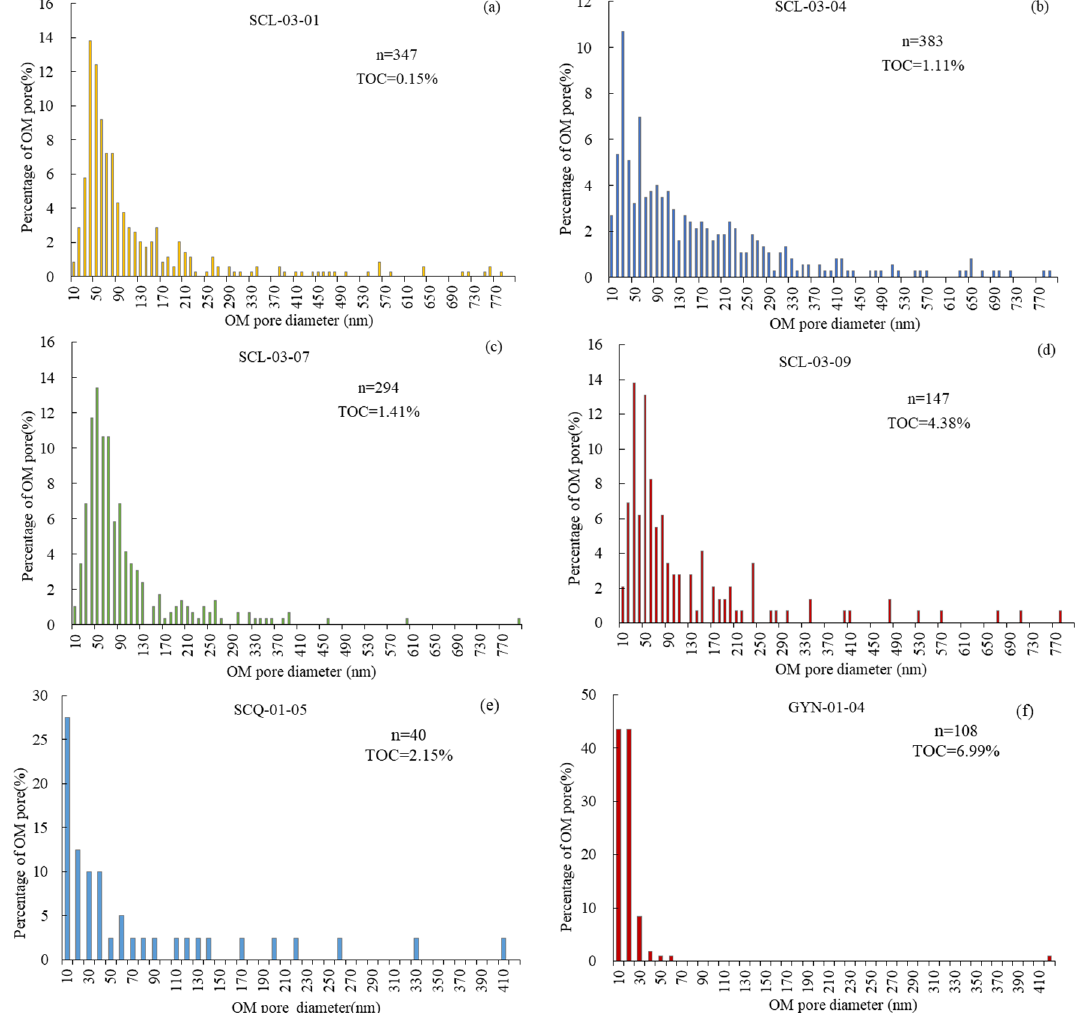
Figure 13. PSD of OM pores in the FE-SEM images of the Lower Paleozoic shale from the upper Yangtze plate (( a – d ) Longmaxi Fm; ( e ) Qiongzhusi Fm; ( f ) Niutitang Fm).